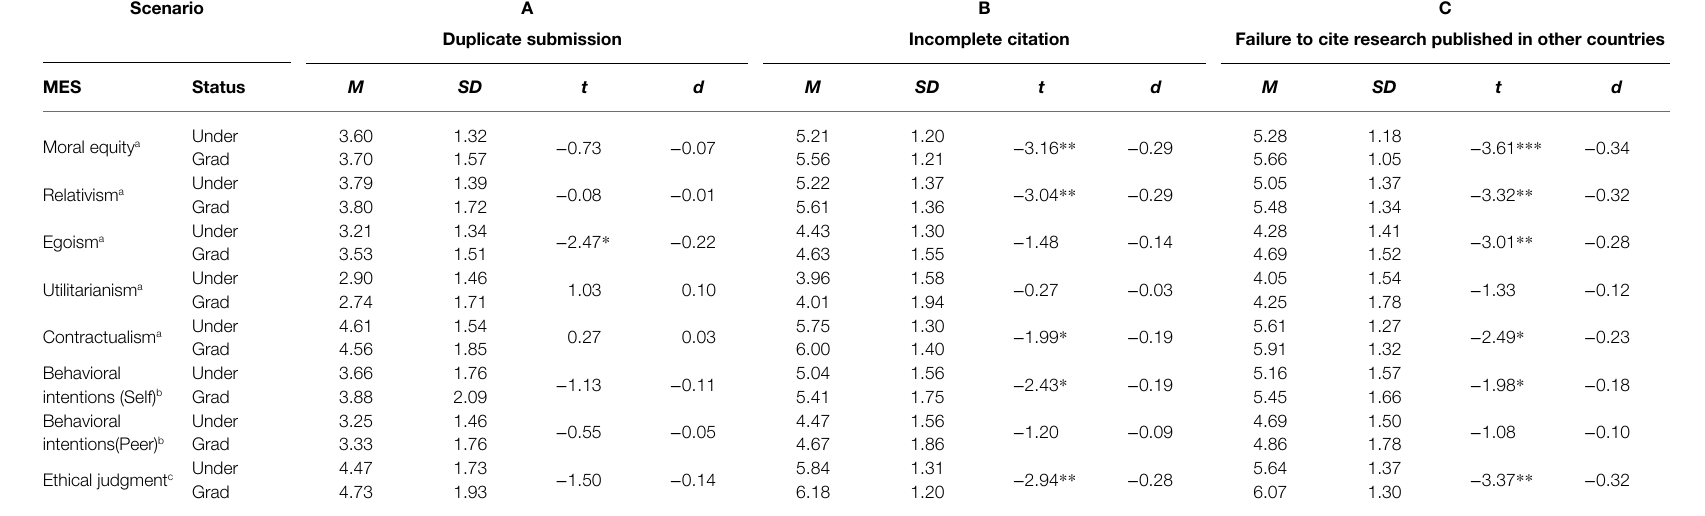
TABLE 4 | Educational level differences in responses across AD